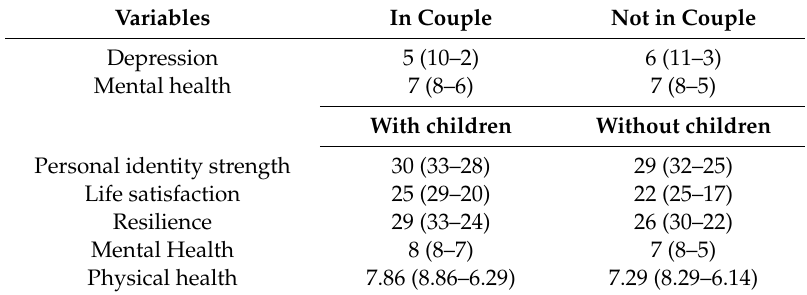
Table 6. Descriptives (Md (IQR)) of the variables with significant di ff erences for “having or not a relationship during confinement” and “having or not